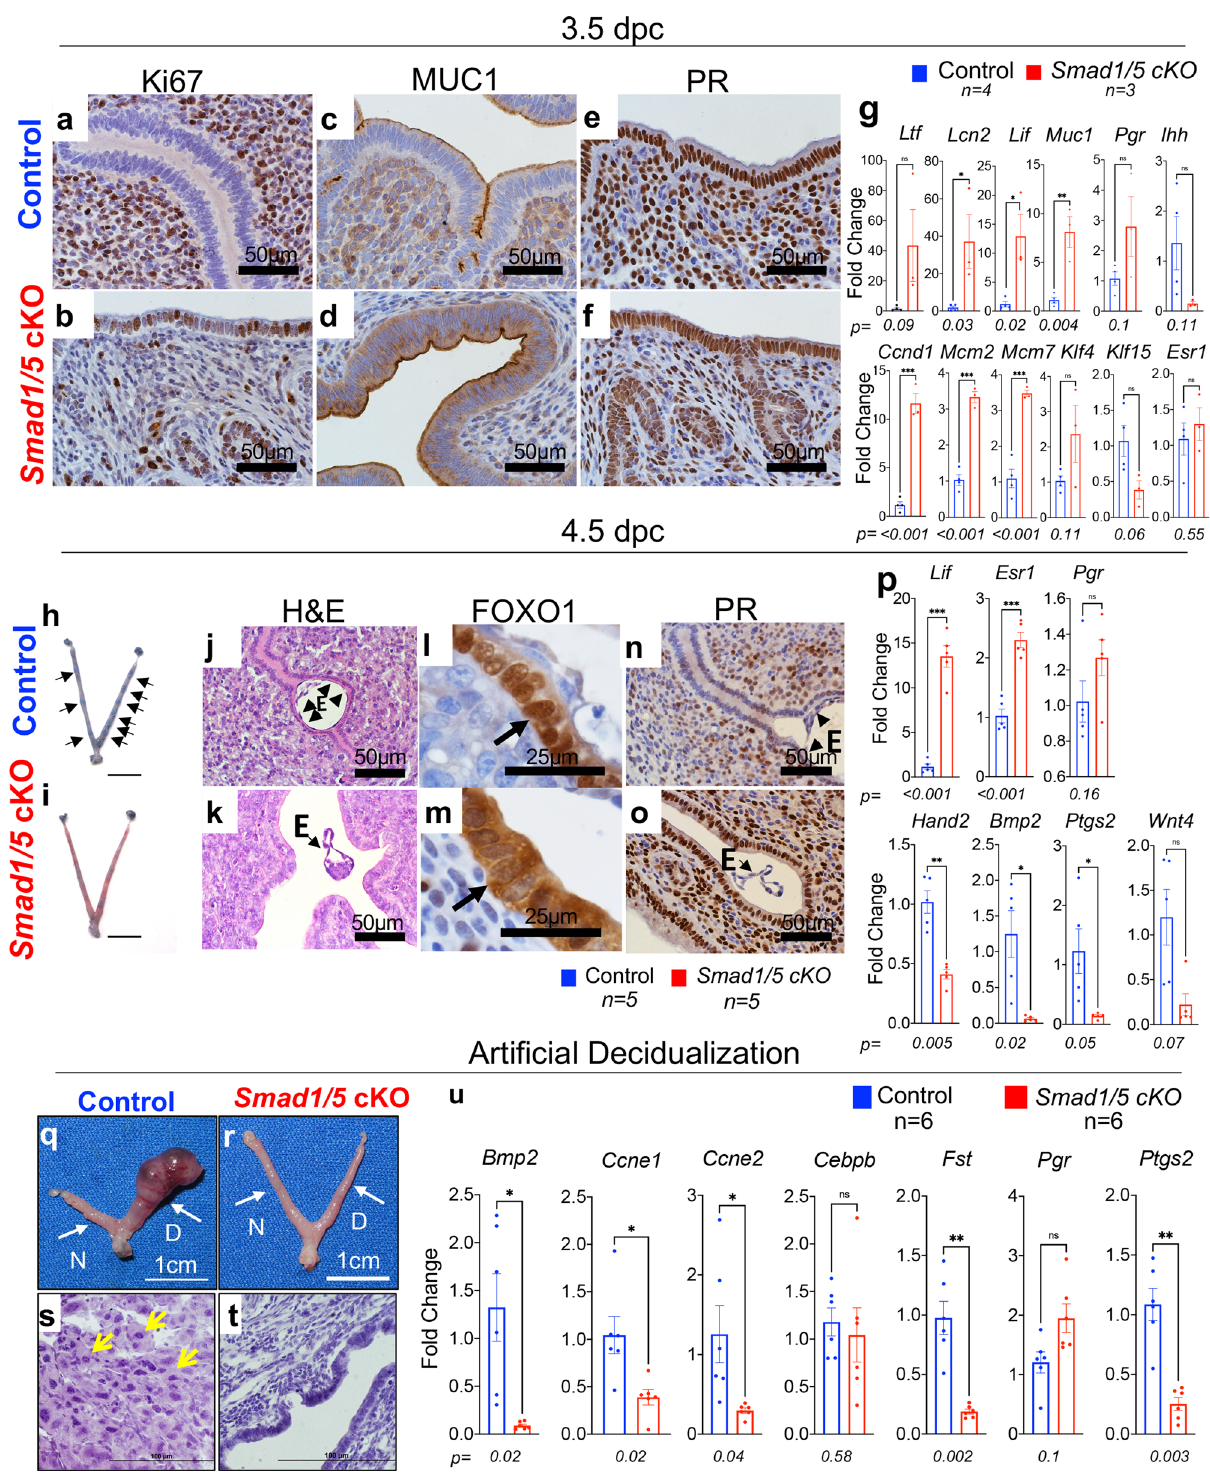
Fig. 3b, d). However, Smad1/5 cKO mice did not show any implantation sites, even after ICI 182,780 administration (Supplementary Fig. 3c, e), indicating that antagonizing ER activity with ICI 182,780 during the window of implantation was not suf fi cient to rescue the implantation defects in the mutant mice. Quanti fi cation of the implantation sites in the control and mutant mice is shown in Supplementary Fig. 3f, and histological analyses of the control implantation sites and mutant uteri are presented in Supplementary Fig. 3g, n.